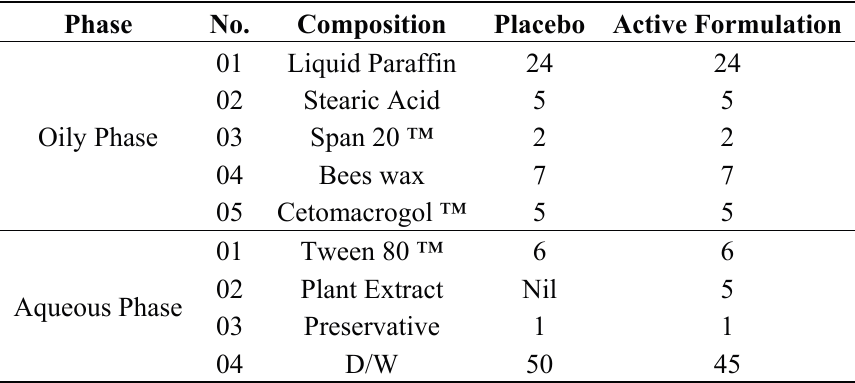
Table 1. Composition of emulsions (% w / w